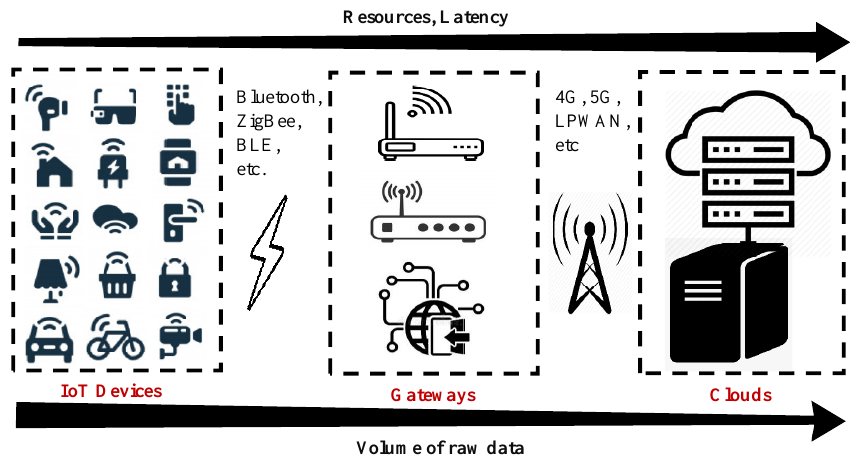
Figure 2. Hierarchical architecture of a generic gateway-based IoT